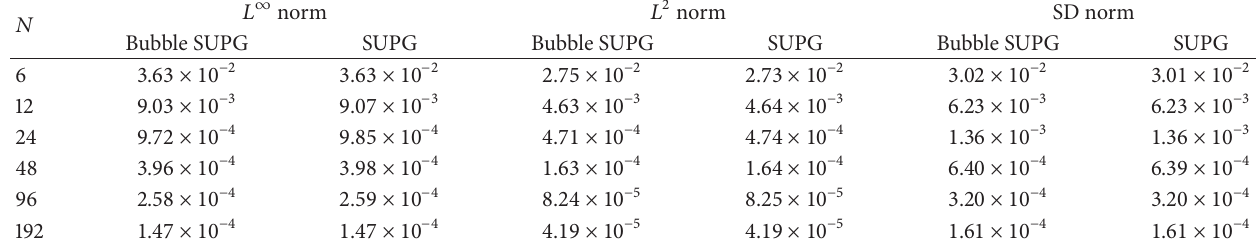
Table 3: 𝜀 = 10 −2 , Problem 1 (comparison of error).